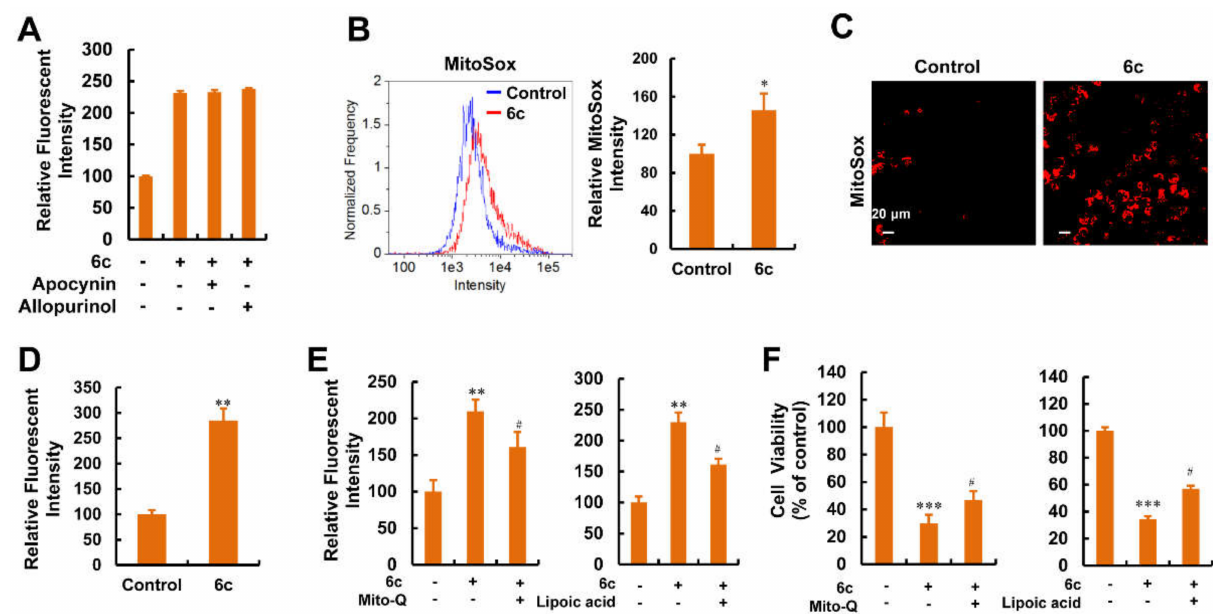
Figure 8. Compound 6c induced mitochondrial ROS generation. ( A ) HepG2 cells were pre-treated by apocynin (300 µ M) and allopurinol (20 µ M) for 1 h before 6c addition. After treatment with 6c (20 µ M) for 6 h, cells were stained with DCFH-DA and detected using HCS. ( B ) HepG2 cells were treated with 6c (20 µ M) for 6 h, the mitochondrial ROS was detected by MitoSox staining using flow cytometry ( n = 3). ( C , D ) HepG2 cells were treated with 6c (20 µ M) for 6 h, the mitochondrial ROS was detected by MitoSox staining using HCS ( n = 3). ( E ) Effects of antioxidants on 6c-induced ROS levels. Before treatment of 6c (20 µ M) for 6 h, HepG2 cells were pre-treated with Mito-Q (1 µ M) and alpha-lipoic acid (200 µ M) for 1 h, respectively. Cells were stained with DCFH-DA and the fluorescence intensity was detected using HCS ( n = 3). ( F ) Antioxidants reversed 6c-induced cell viability inhibition to varying degrees. After pre-treatment of Mito-Q (1 µ M) and alpha-lipoic acid (200 µ M) for 1 h, respectively, HepG2 cells were exposed to 6c (20 µ M) for another 24 h followed by the detection of cell viability using MTT assays ( n = 3). * p < 0.05, ** p < 0.01 and *** p < 0.001 vs. untreated groups; # p < 0.05 vs. 6c treatment